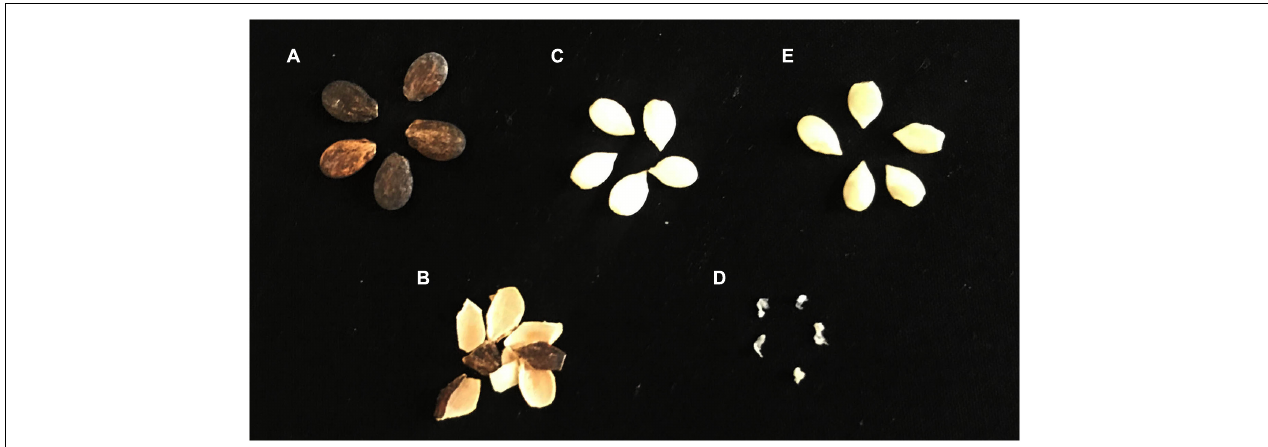
FIGURE 1 | Excision of watermelon seed embryos after seed decoating and surface sterilization, the removal of perisperm tissues, and monitoring the seed embryo homogenate for cultivable bacteria. (A) Whole dry seeds, (B) removed seed coat, (C) seed embryo with perisperm, (D) perisperm tissue removed during sodium hypochlorite-mediated surface sterilization, and (E) surface-sterilized embryo with the perisperm tissue